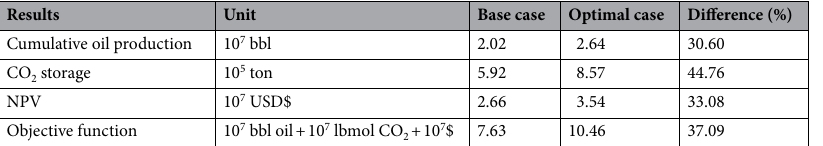
Table 5. Comparison between the base case and the optimal solution.